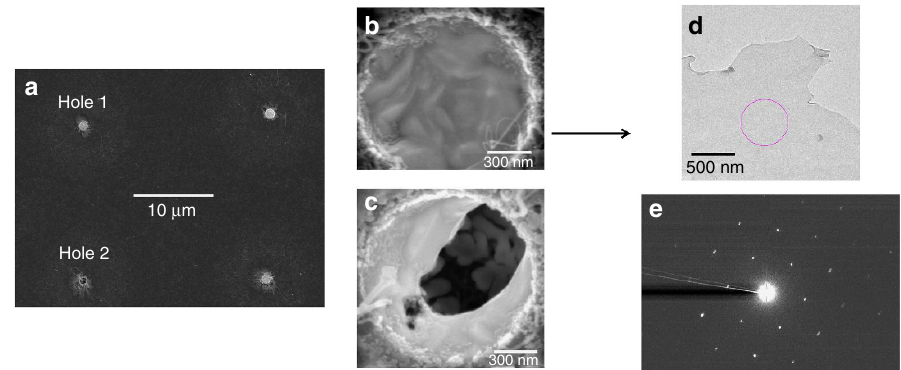
Figure 5 | Lateral growth of single domain free-standing graphene on diamond. ( a ) Successful growth of graphene on four holes is presented. ( b ) Full coverage of hole 1 is demonstrated. ( c ) Graphene partially grown on the hole 2 confirms free-standing nature. ( d ) TEM image confirms a single-domain graphene growth with ( e ) selected area electron diffraction (SAED) pattern indicating diffraction of single-domain graphene film. The circle in d highlights the area where SAED pattern was recorded.